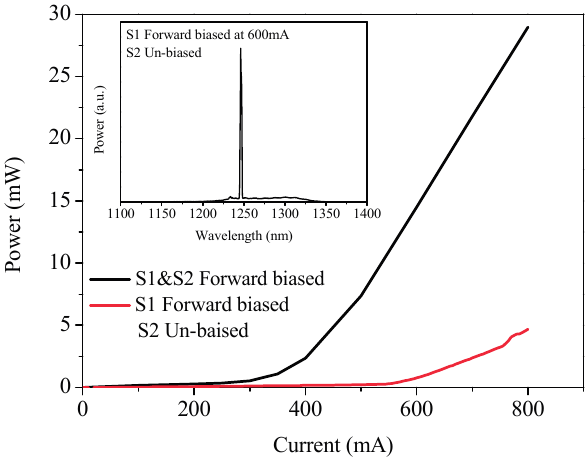
Figure 7. ( a ) Measured light-current (L-I) characteristics of the two-section InAs/GaAs QDs device on Si with different absorber biasing conditions. The black curve is for the situation that both S1 and S2 were forward biased under the same pumping conditions. The red curve is for the situations that S1 was forward biased while S2 was un-biased. ( b ) Measured lasing spectrum under the conditions that S1 was forward biased at an injection current of 600 mA with S2 was